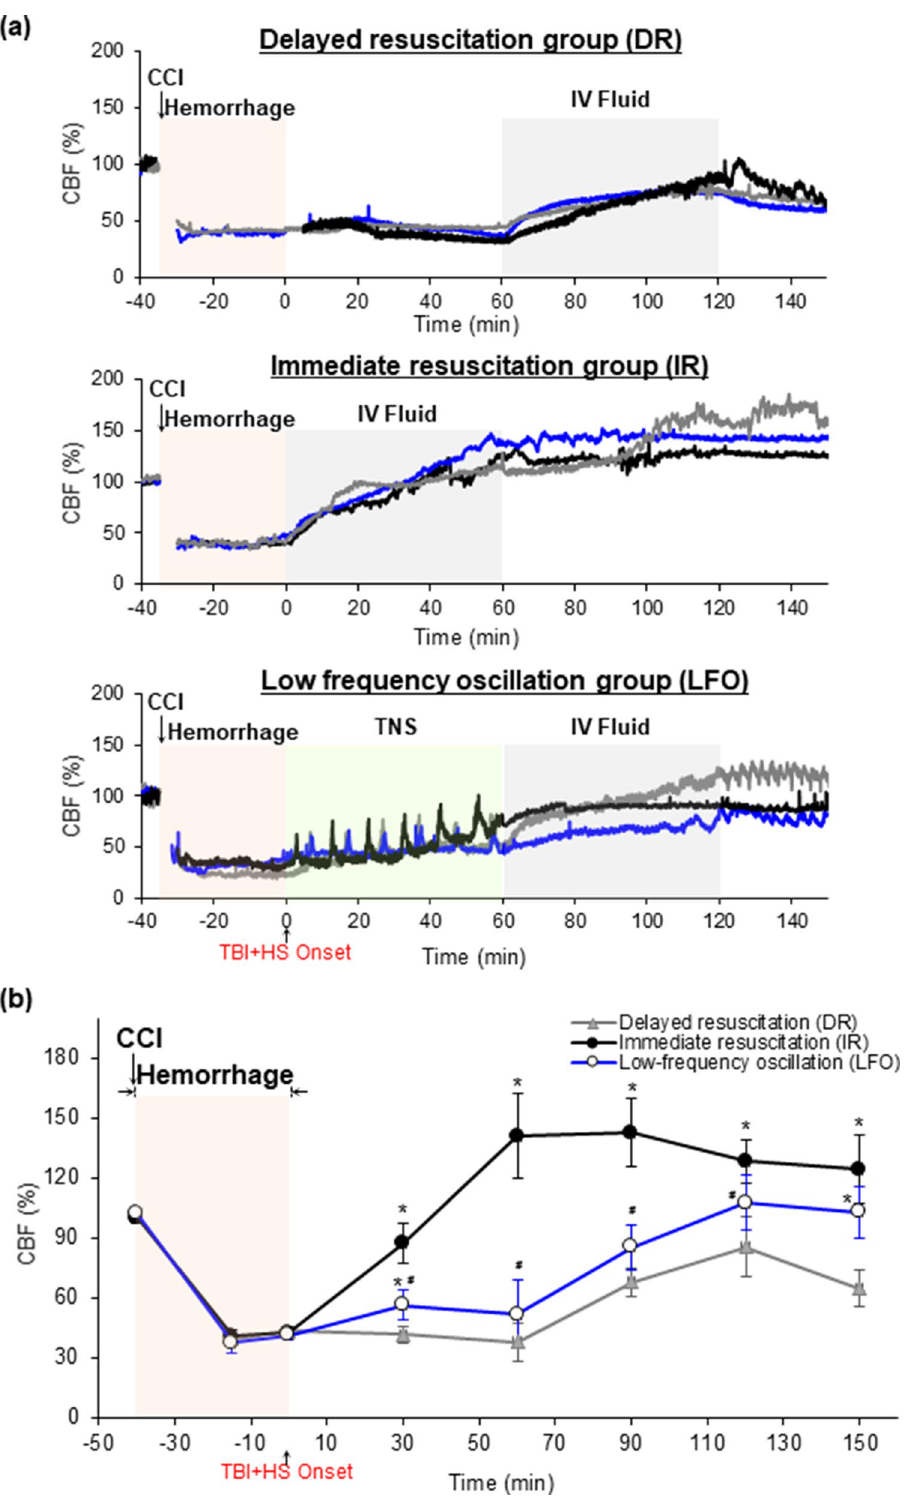
Figure 2. ( a ) The representative recordings of CBF from each experimental group before, during, and after TBI + HS. Pink box: during hemorrhage; Gray box: during fluid resuscitation; Green box: during TNS-induced CBF oscillations at 0.1 Hz. n = 3/group. ( b ) Effect of delayed and immediate fluid resuscitation, TNS-induced CBF oscillations on cerebral hemodynamics following TBI + HS. All of the data are presented as mean ± SD. * p < 0.05 versus DR, # p < 0.05 versus IR, n = 10 for each group. CBF: cerebral blood flow; CCI: controlled cortical impact; IV: intravenous; TNS: trigeminal nerve